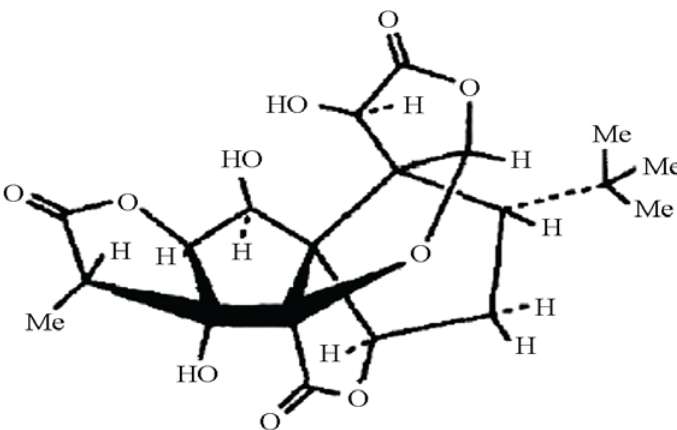
Figure 8. Structure of Ginkolide